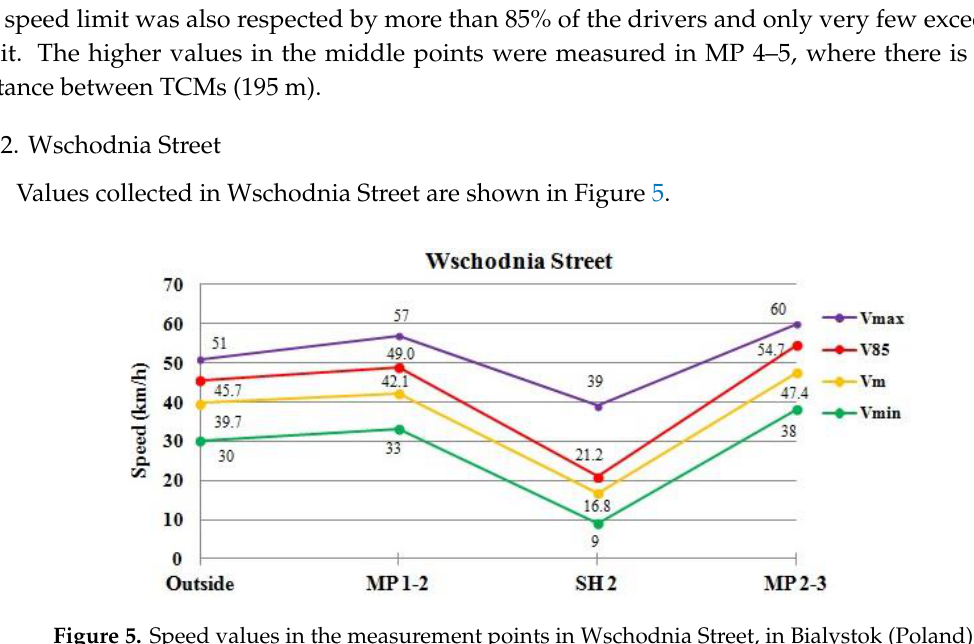
Figure 5. Speed values in the measurement points in Wschodnia Street, in Bialystok (Poland).